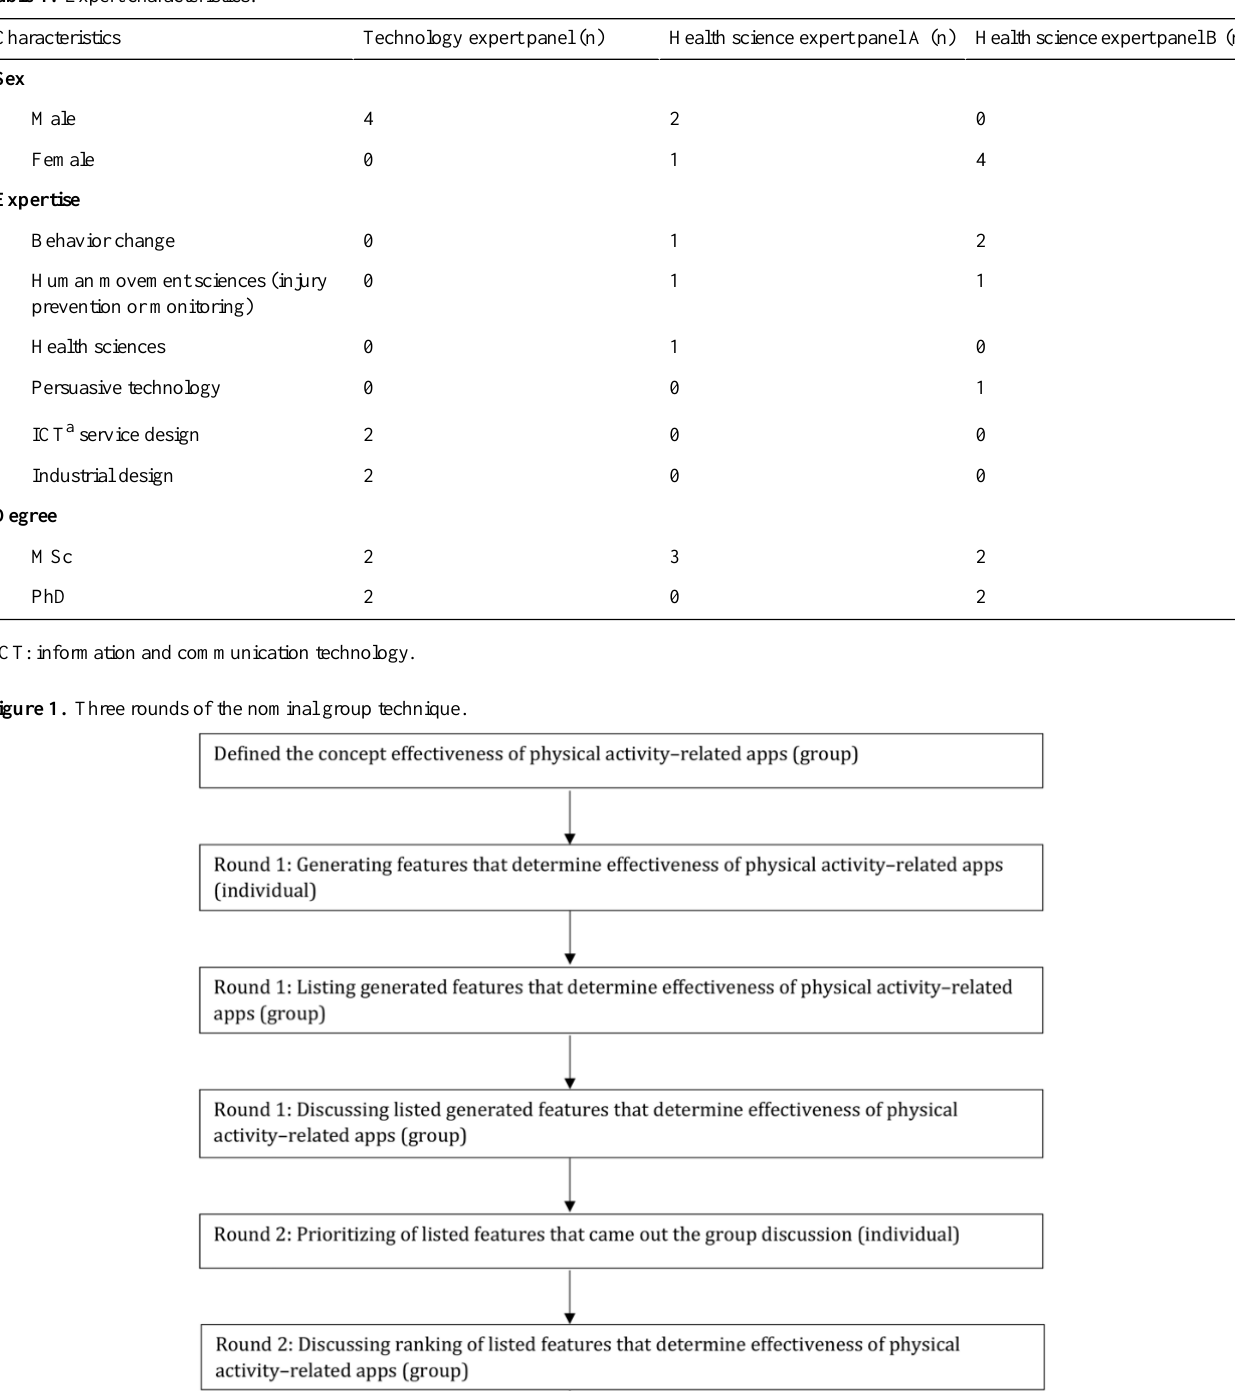
Table 1. Expert characteristics.